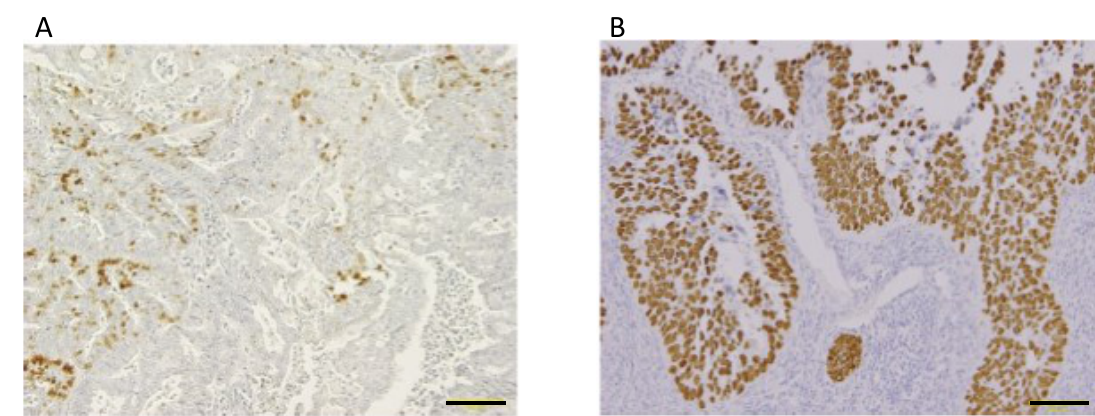
Figure 2. Immunohistochemical localization of p53 proteins in representative cases of endometrial endometrioid carcinoma. A , Grade 1 endometrial endometrioid carcinoma with low-positive p53-staining. B , Grade 2 endometrial endometrioid carcinoma with high-positive p53-staining. Scale bars: 100 μm.